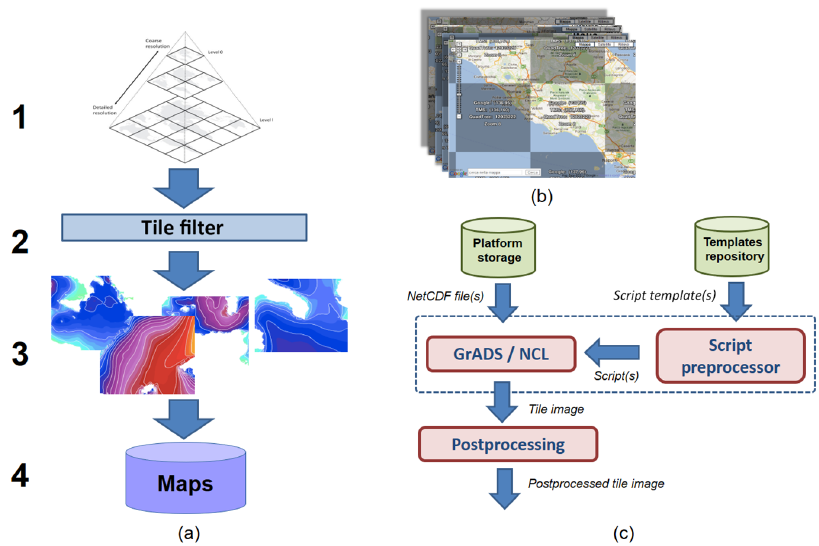
Figure 4. Tiled map